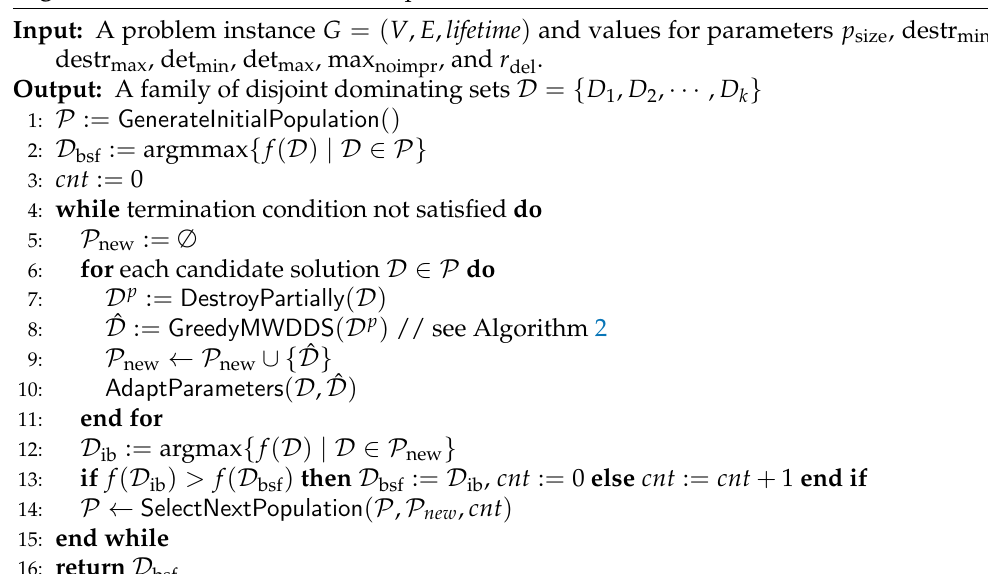
Algorithm 1 PBIG for the MWDDS